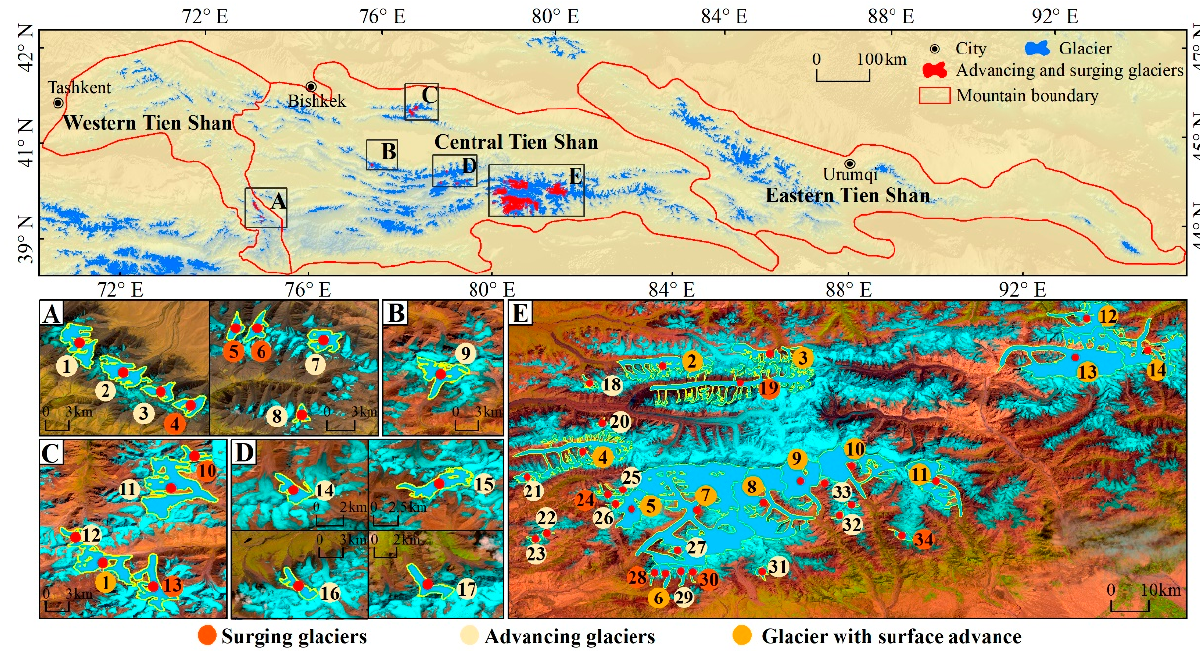
Figure 6. Distribution of advancing and surging glaciers in the western, central, and eastern Tien Shan region (background: the main figure shows an ASTER GDEM V2 product of the Tien Shan Range; ( A – E ) Landsat Operational Land Imager (OLI) image (Bands 6, 5, and 2); the images are LC81500322016266LGN02, LC81490312016259LGN01, LC81490302016259LGN01, LC81480312018225LGN00, and